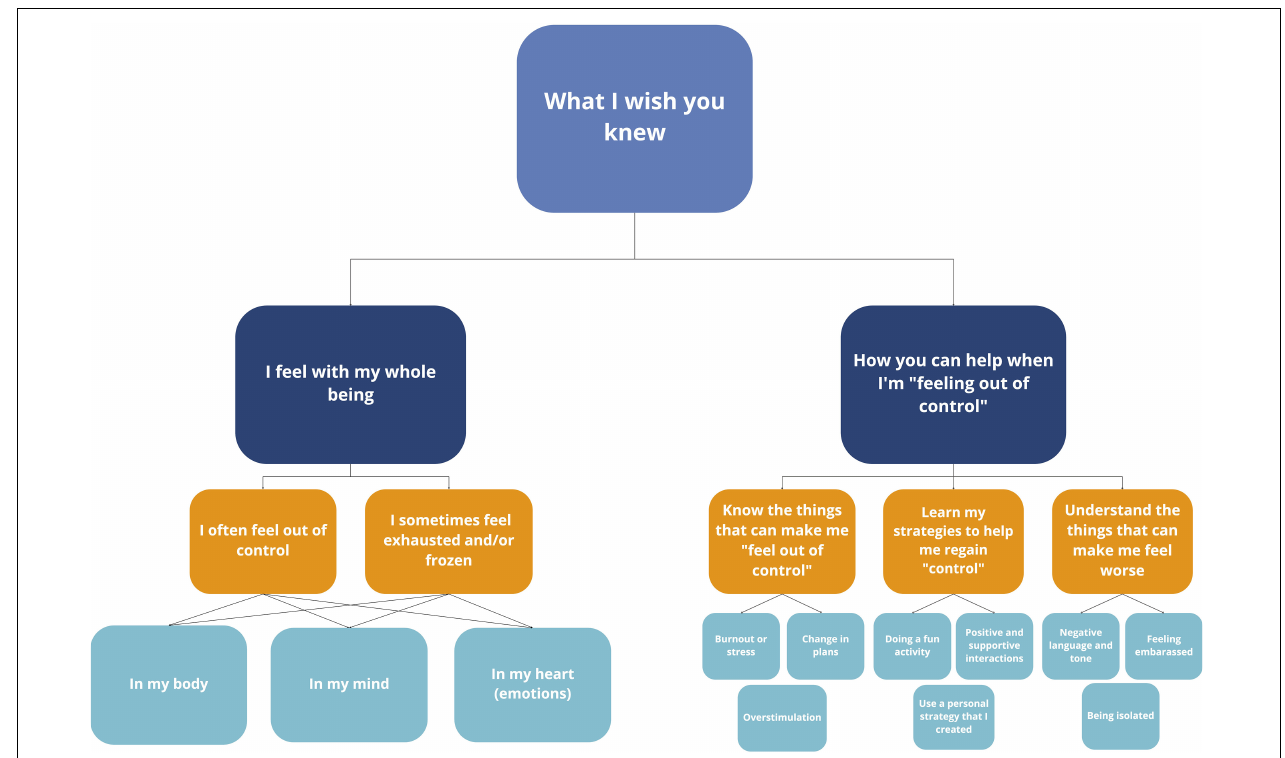
FIGURE 1 | Text provided in quotation marks represent direct quotations from